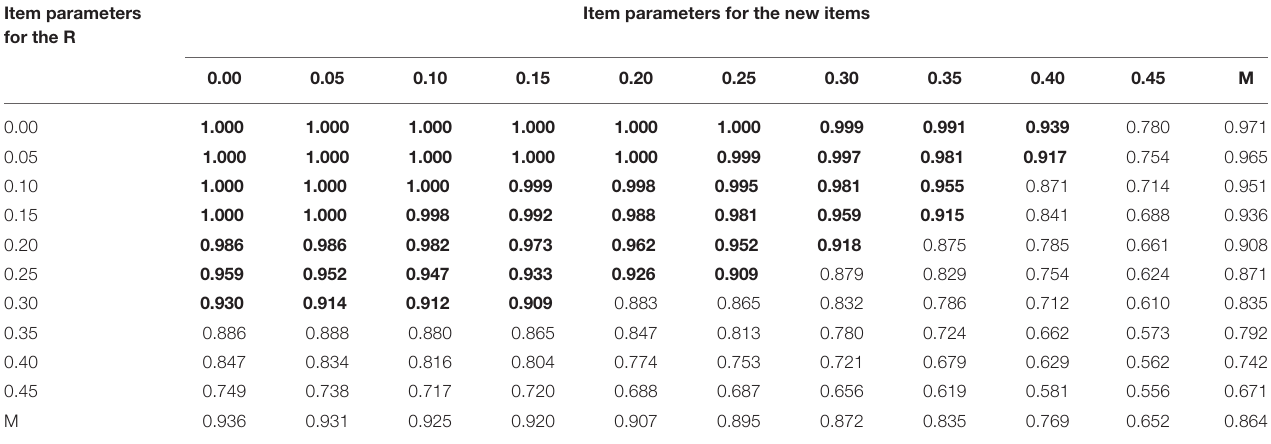
TABLE 2 | The correct recovery rates of q-entries with sample size of 300 for the DINA model and random design. Item parameters for the R